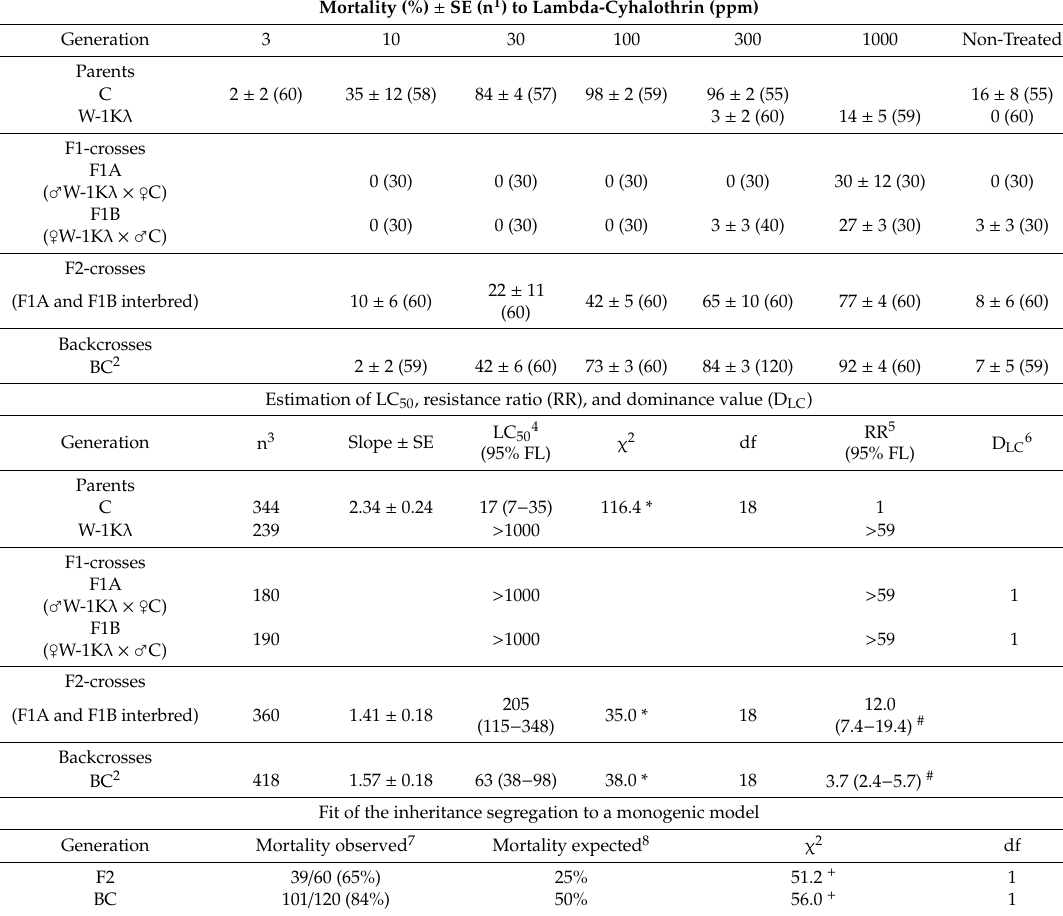
Table 1. Study of the inheritance of resistance to lambda-cyhalothrin in the W-1K λ strain of Ceratitis capitata